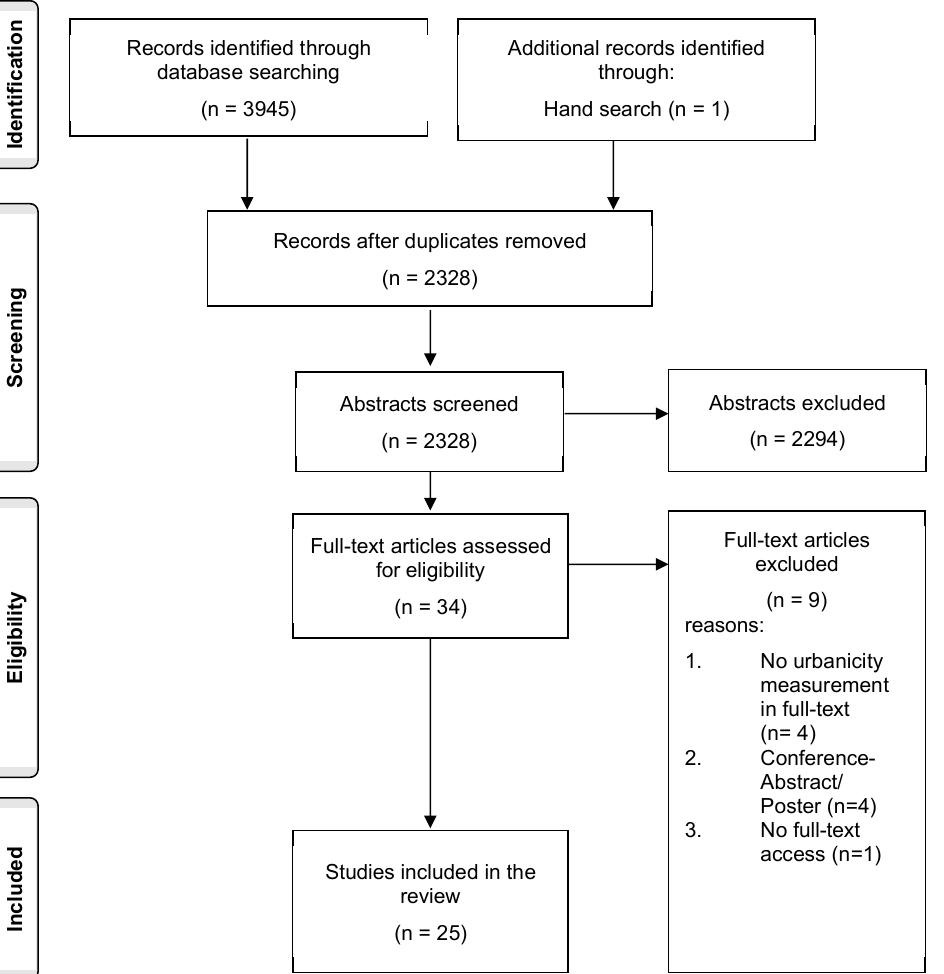
Figure 1. Flowchart of study selection progress.